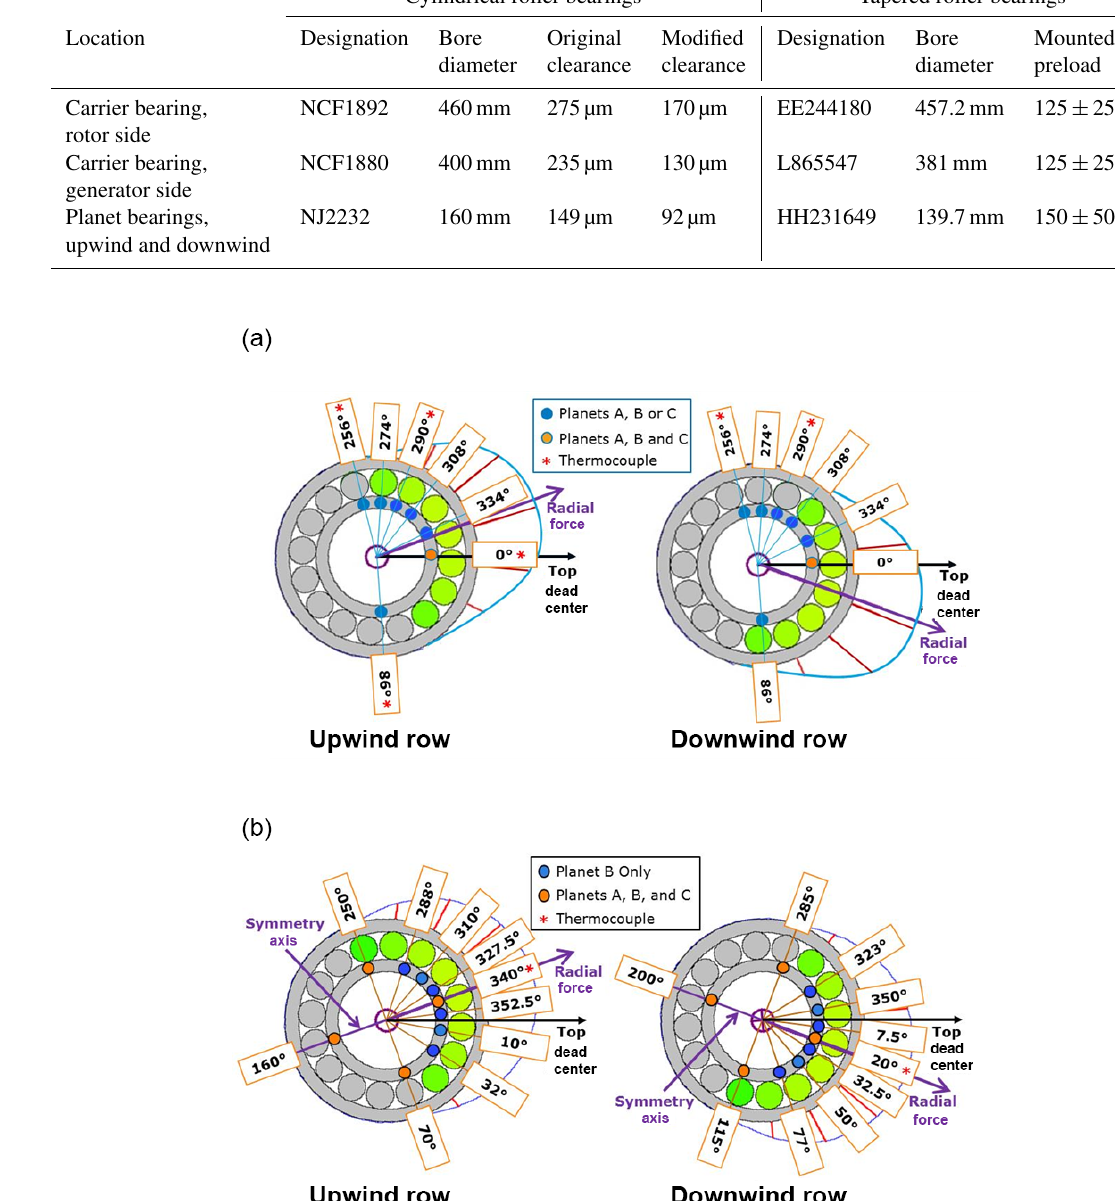
with preloaded TRBs, the measurements focused on the cir- cumferential load distribution with only one axial measure- ment on each bearing inner race. Additionally, one planet (B) has measurements at 10 circumferential locations per bear- ing row, 9 of which span the expected load zone. The other two planets (A and C) have measurements at four circumfer- ential locations per bearing row (Keller and Wallen, 2017).